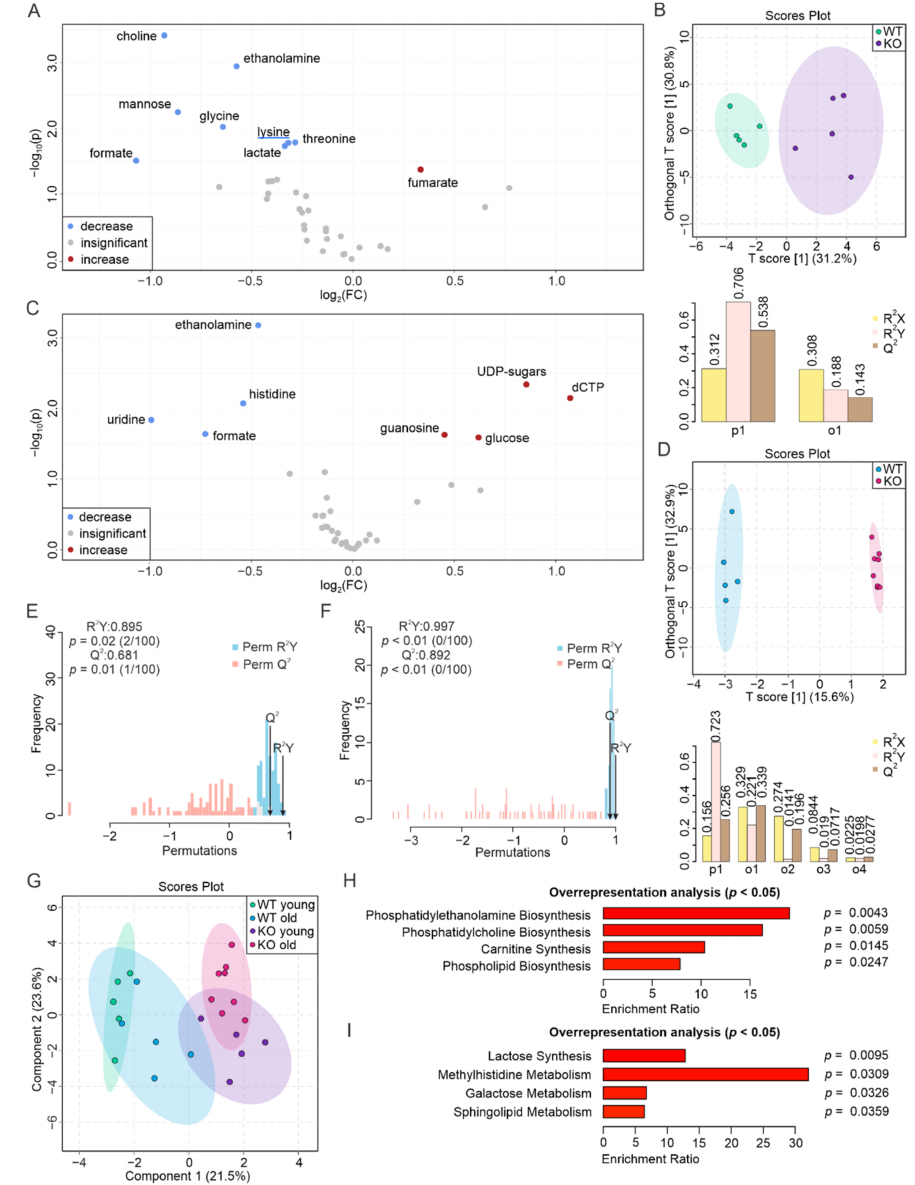
Figure 6. PEMT deficiency affects metabolic stability of young and old duodena. ( A ) Volcano plot showing differences in the metabolite concentrations between WT and PEMT KO duodenum from young mice. Red and blue corresponds to significantly increased and decreased metabolites, respectively. Grey dots denote metabolites with insignificant changes. Blue underline indicates an aging biomarker whose concentration decreases in the aged WT duodenum. ( B ) O-PLS-DA plot of WT ( n = 5, green) and KO ( n = 5, purple) duodenum samples from young mice (upper panel), and model quality assessment for p1 and o1 with cross-validation coefficients R 2 X, R 2 Y, and Q 2 (lower panel). ( C ) Volcano plot showing differences in the metabolite concentrations between WT and PEMT KO duodena from aged mice. ( D ) O-PLS-DA plot of WT ( n = 5, blue) and KO ( n = 8, pink) duodenum samples from aged mice (upper panel), and model quality assessment for p1 and four orthogonal components (o1, o2, o3, and o4) with cross-validation coefficients R 2 X, R 2 Y, and Q 2 (lower panel). ( E ) Histogram of permutation test for samples in ( B ) and ( F ) for samples in ( D ) with permutation number n = 100, respectively. ( G ) S-PLS-DA plot of the 4 duodenum groups, with green, purple, blue, and pink corresponding to WT young, KO young, WT old, and KO old, respectively. ( H ) ORA of pathways associated with significantly changed metabolites in the duodenum of ( A ) young mice and ( I ) of aged mice ( C ), with all pathways yielding p <